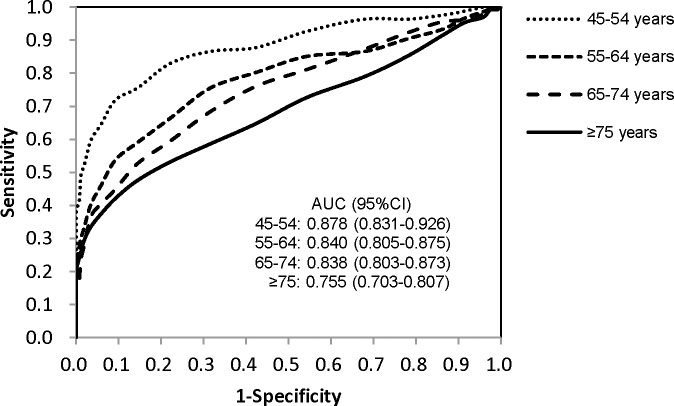
ROC curves of HbA1c for diagnosing diabetes in different age groups.The areas under the curve (AUCs) were 0.878, 0.840, 0.838 and 0.755, respectively with 10 years incrementally increased from 45 years to ≥75 years.